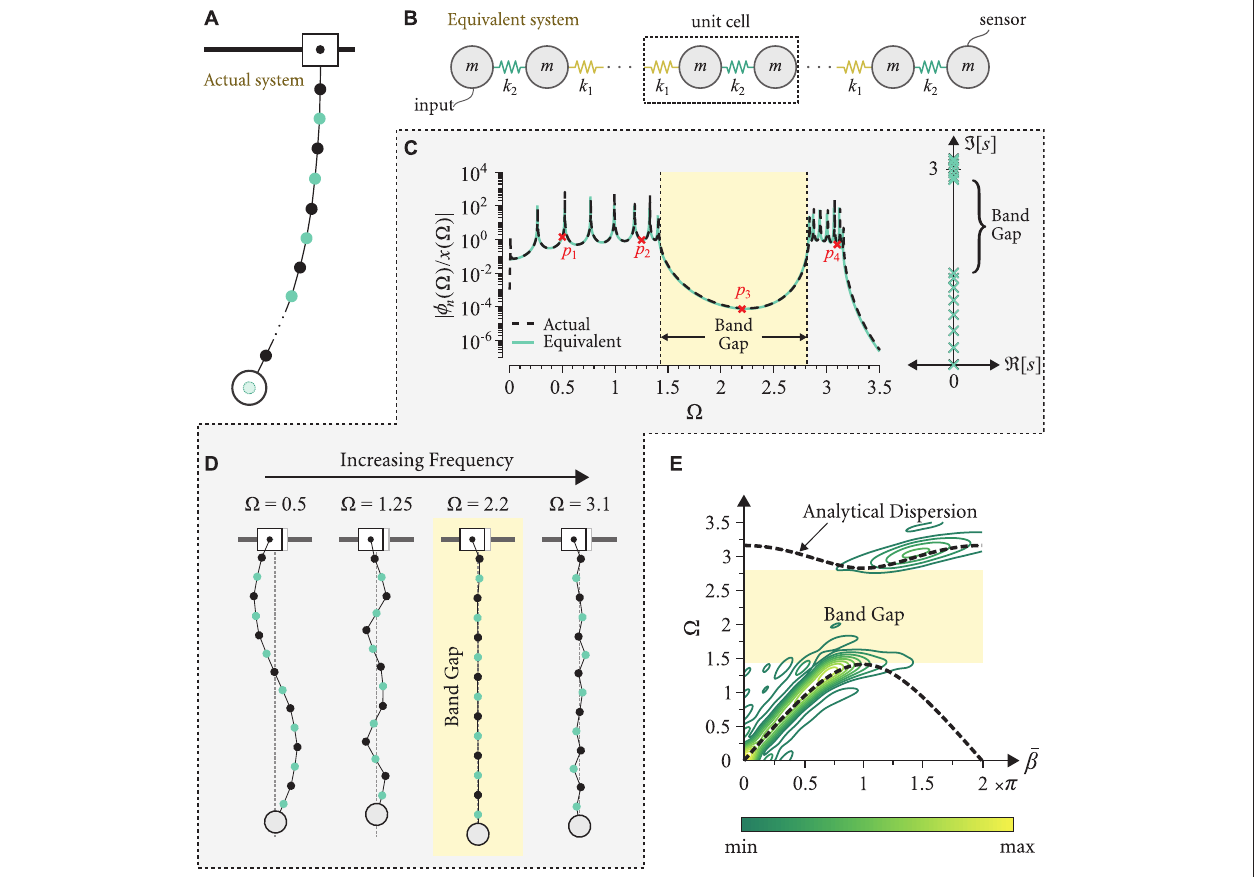
15, µ 0.25, ̺ 10 3 and ℓ 1 (left) and its corresponding poles distribution (right). (D) An illustrative = = = = 4 on the frequency response). (E) −